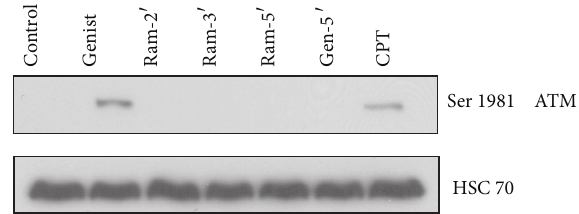
Figure 7: ATM activation in HCT 116wt cells treated with genistein (100 𝜇 M), camptothecin CPT (1 𝜇 M), and genistein derivatives substituted at C4 󸀠 at the concentration equivalent to 3x IC 50 (Ram-2 󸀠 (3 𝜇 M), Ram-3 󸀠 (40 𝜇 M), Ram-5 󸀠 (20 𝜇 M), Gen-5 󸀠 (20 𝜇 M). HSC 70 served as a loading control.